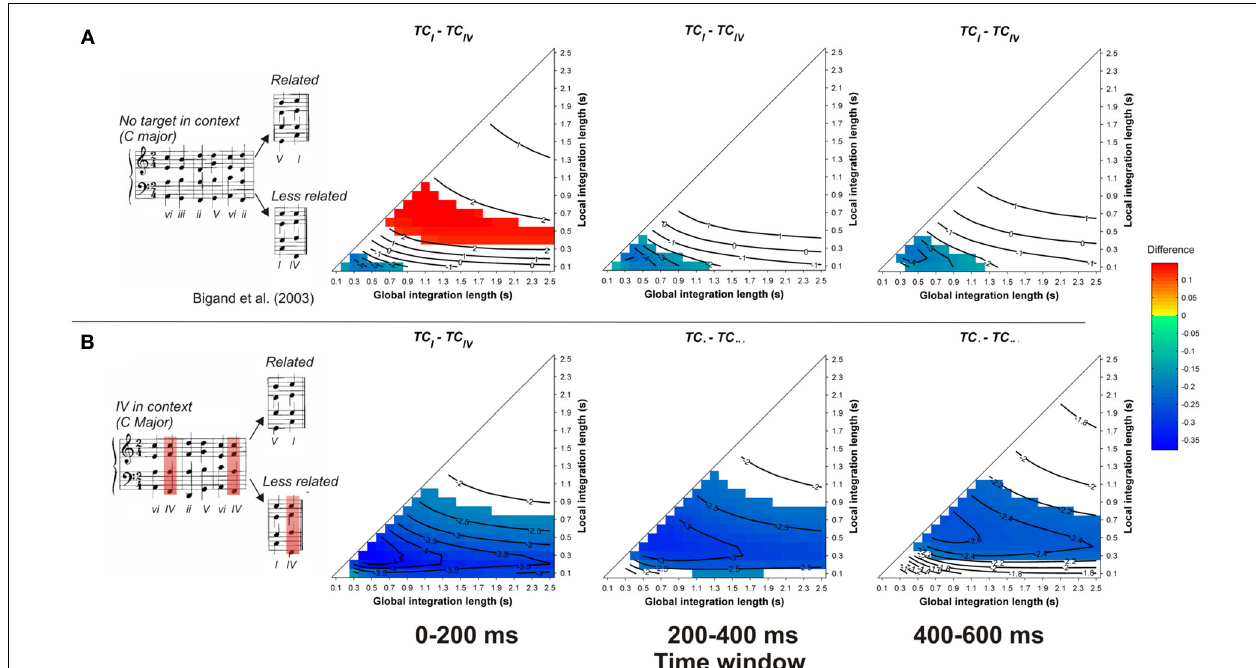
FIGURE 5 | Each row represents one experimental condition used by Bigand et al. (2003), in which the less-related target chord appeared in the context (B) or not (A). Example sequences of each condition are given in inserts . Each column represents the mean differences between TC related and TC less _ related for a different